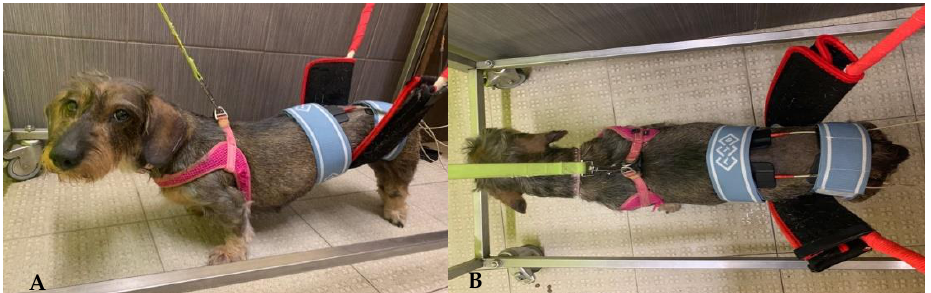
Figure 2. ( A , B ) Transcutaneous electrical spinal cord stimulation. One electrode placed on L1-L2 and the other one on L7-S1.